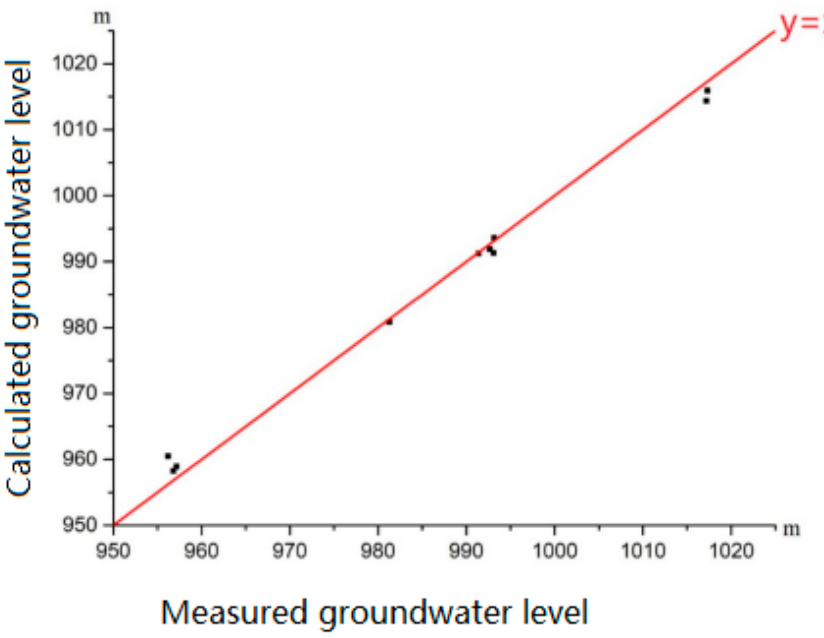
Figure 8. Contour map of groundwater level in the study area with five karst pipes. 4.3. Groundwater Level Analysis of Dam Site during the Reservoir Operation During the reservoir operation, the seepage control and drainage measures for un- derground buildings were used in the dam site. Drainage holes have been installed in an underground powerhouse. Impervious curtain was arranged in the dam foundation and both banks and extended to the position of karst pipes. It mainly discusses the variable of